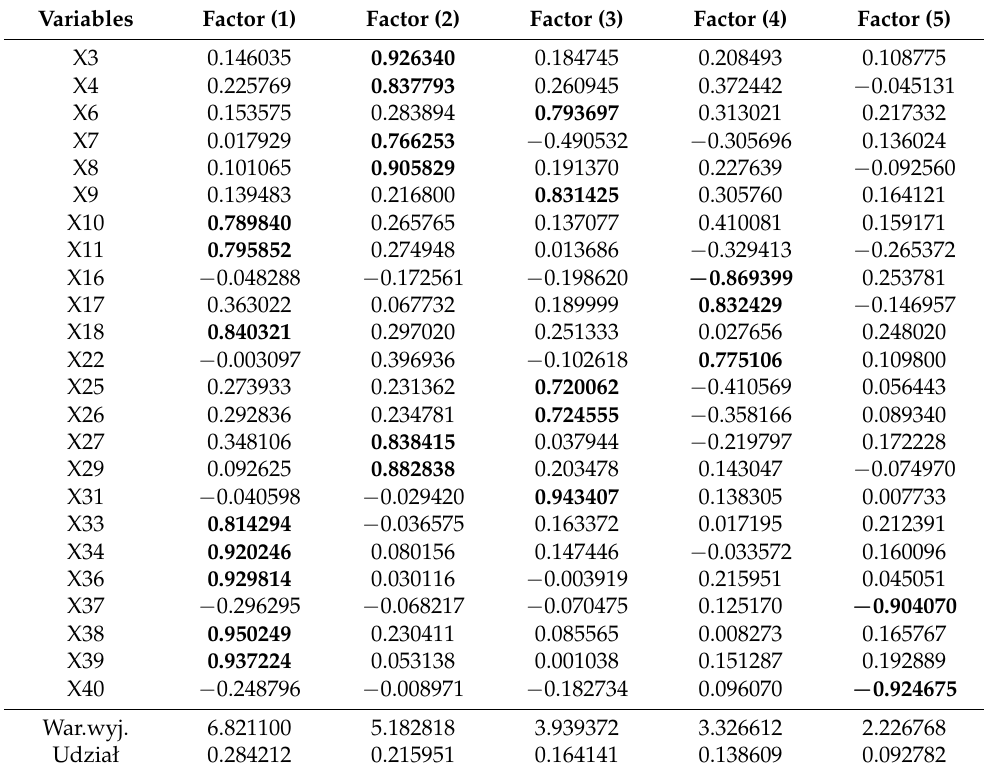
Table 3. Values of factor loadings after rotation with the ‘Varimax’